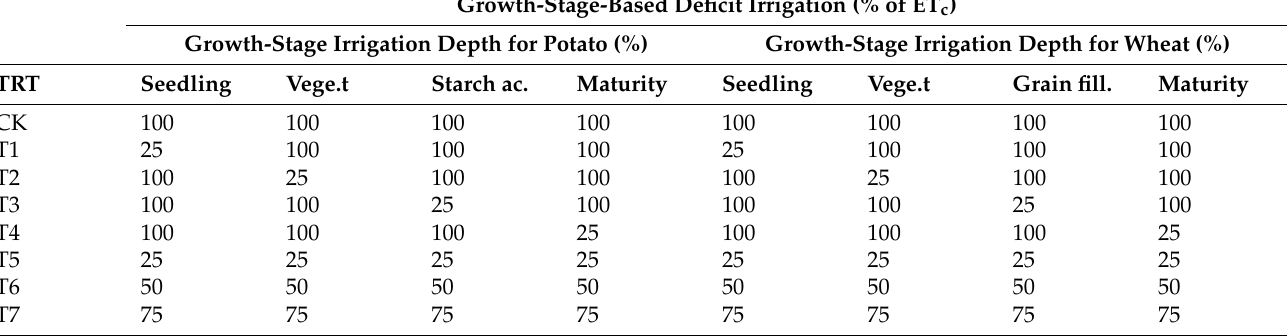
Table 2. Irrigation-scheduling treatments: irrigation-depth percentage based on ET c . Growth-Stage-Based Deficit Irrigation (% of ET c ) Growth-Stage Irrigation Depth for Potato (%) Growth-Stage Irrigation Depth for Wheat